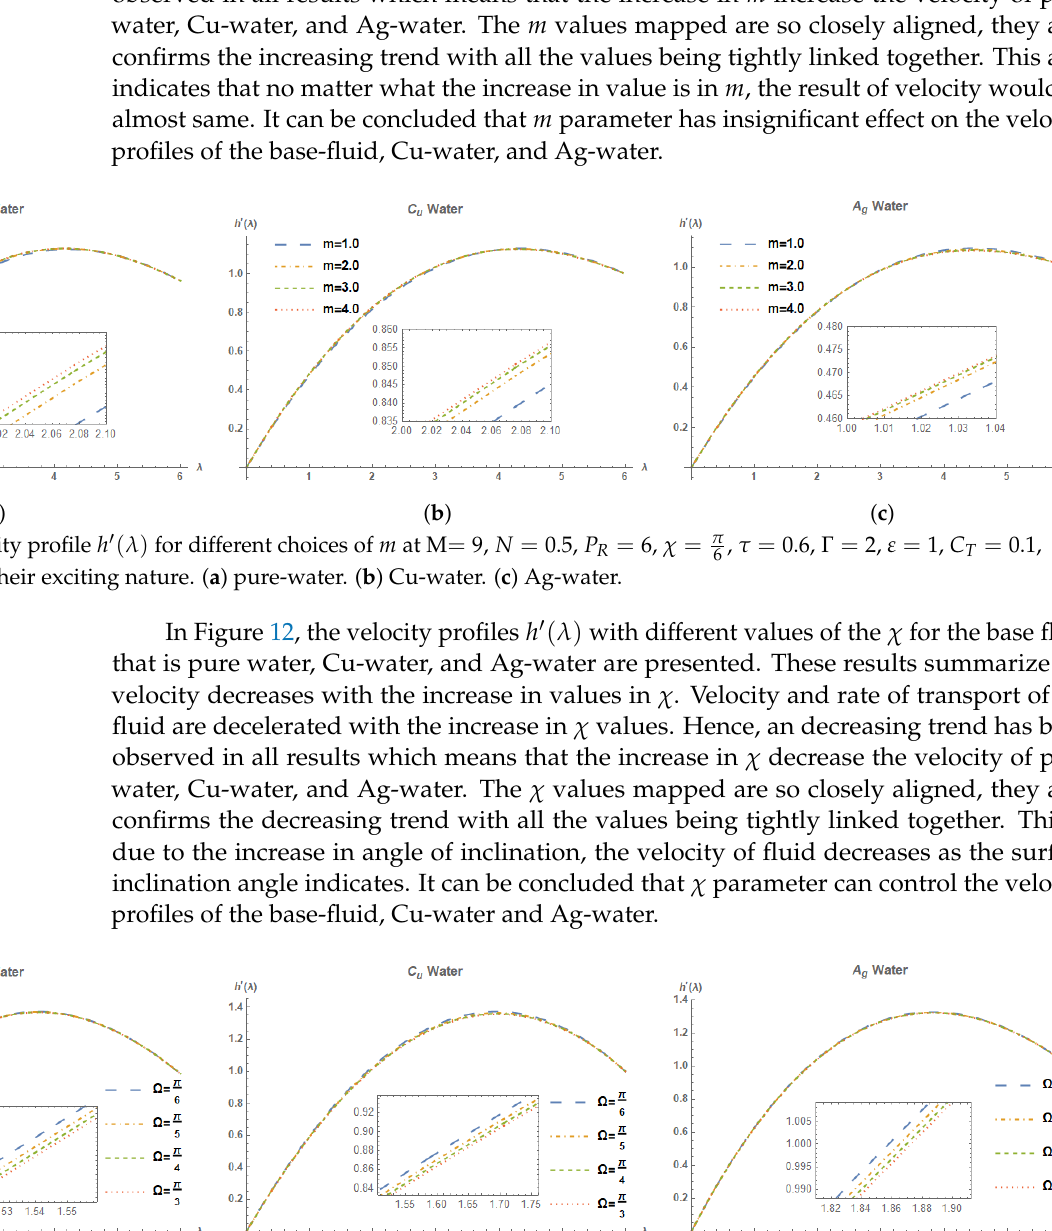
Figure 12. Velocity profile h (cid:48) ( λ ) for different choices of χ at M = 9, N = 0.5, P R = 6, τ = 0.6, Γ = 2, ε = 1, C T = 0.1, S = 1 showing their exciting nature. ( a ) pure-water. ( b ) Cu-water. ( c )